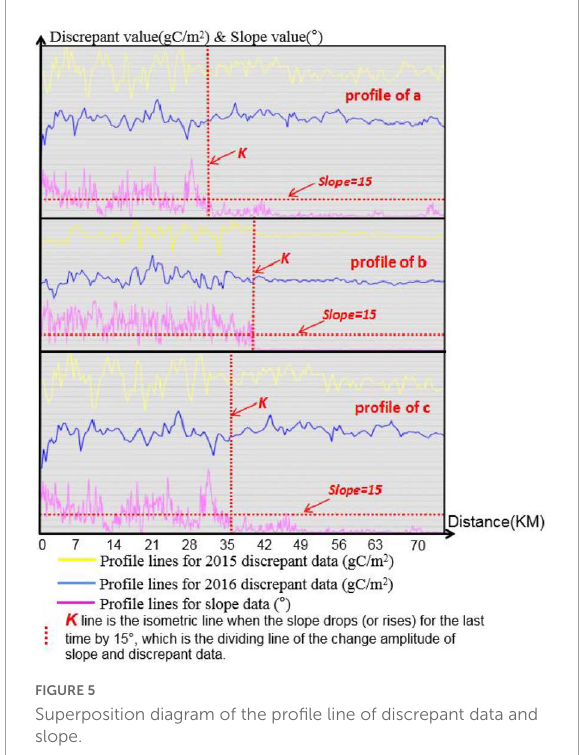
FIGURE5 Superposition diagram of the profile line of discrepant data and